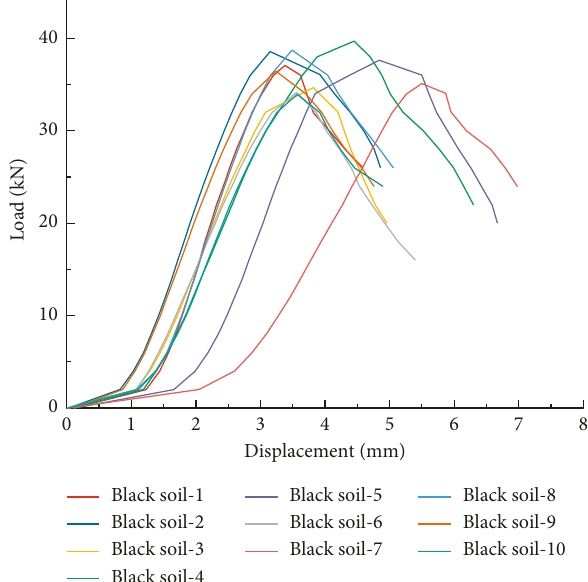
Figure 8: The Load-displacement curve of black